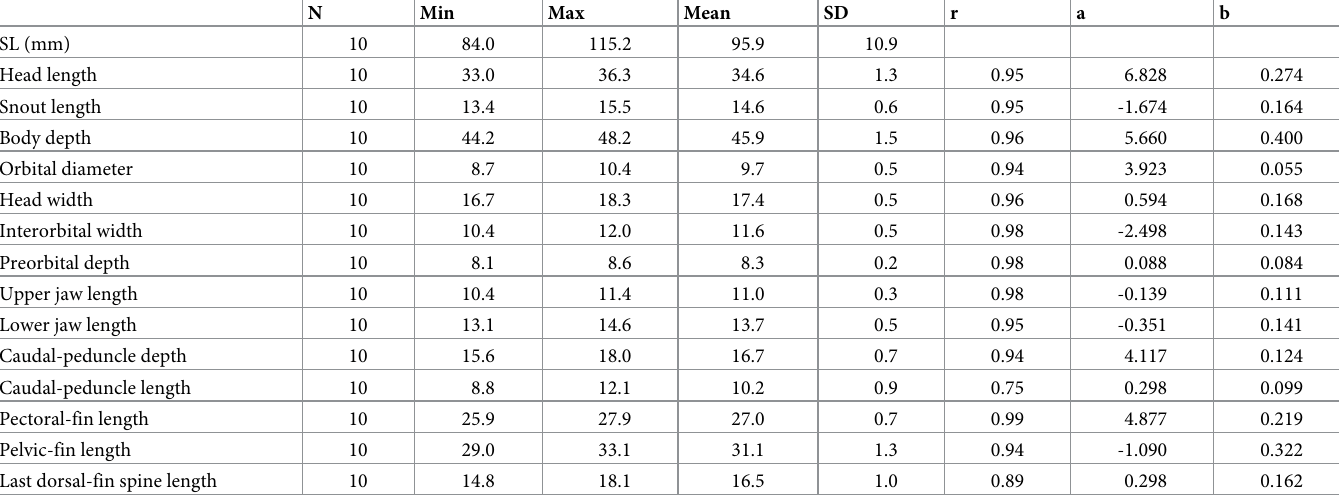
Australoheros examined here. This was not supported by traditional ratio data, however, in which all species overlapped (Tables 10–19). Large samples showed wide ranges representing aberrant specimens or samples of reduced breeder sizes. Australoheros sanguineus was distin- guished with somewhat deeper body than the rest, and A . ricani and A . mboapari had more elongate body, longer snout and deeper preorbital than remaining species. Regression analysis of the distance measurements on SL failed the hypothesis of a common slope in all of them (p = 0–0.0212). Variation, however, may have been influenced by different size ranges in spe- cies samples, and increased variability among large specimens, irrespective of species. Body depth, indicated as distinguishing A . mboapari in the PCA, had the same slope as in A . min- uano and A . ricani when these three species were analysed alone. Table 19. Australoheros sp. “Jacuı´”. Size (SL), proportional measurements (per cent of SL), and linear regression parameters. N